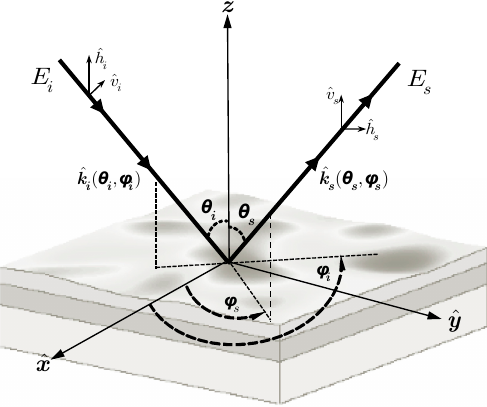
Figure 1. A geometry of rough surface scattering.